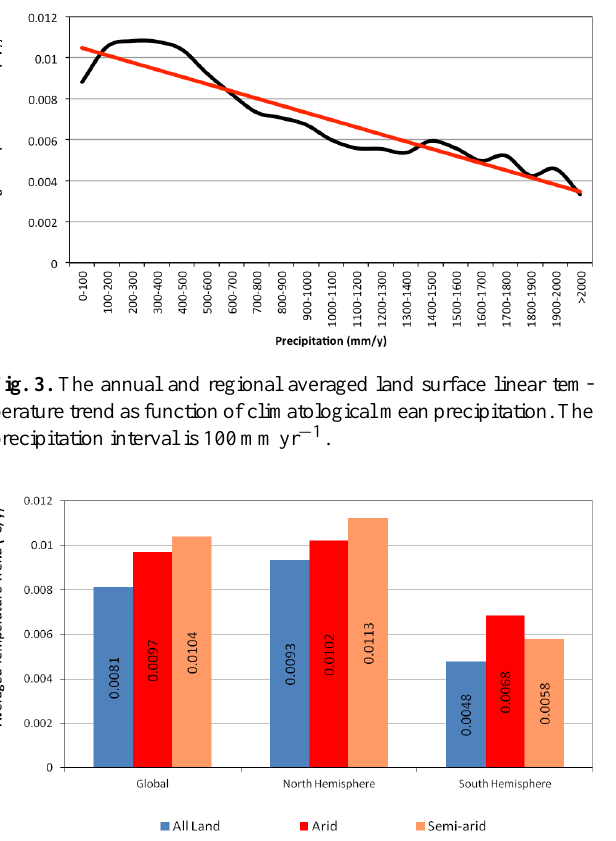
Fig. 4. The averaged temperature trend for arid region, semi-arid region and all land over Global, Northern Hemisphere (NH), and Southern Hemisphere